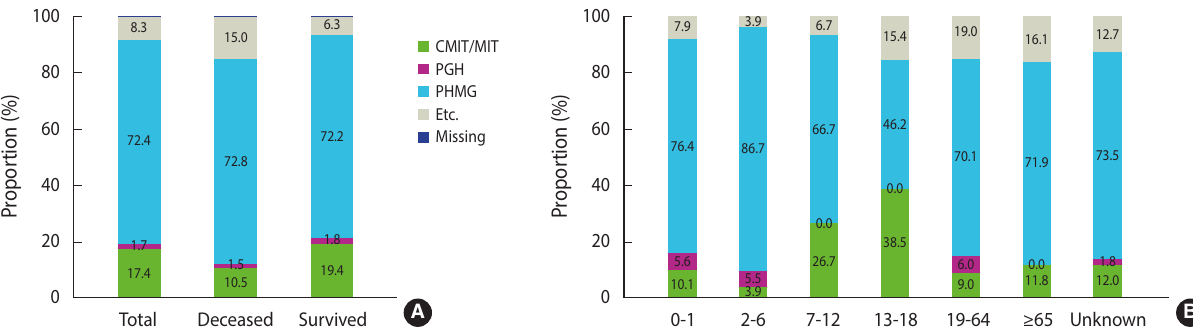
Figure 1. Overall distribution of the components used in humidifier disinfectants (A) and distribution by age (B). CMIT/MIT, chloromethyli-